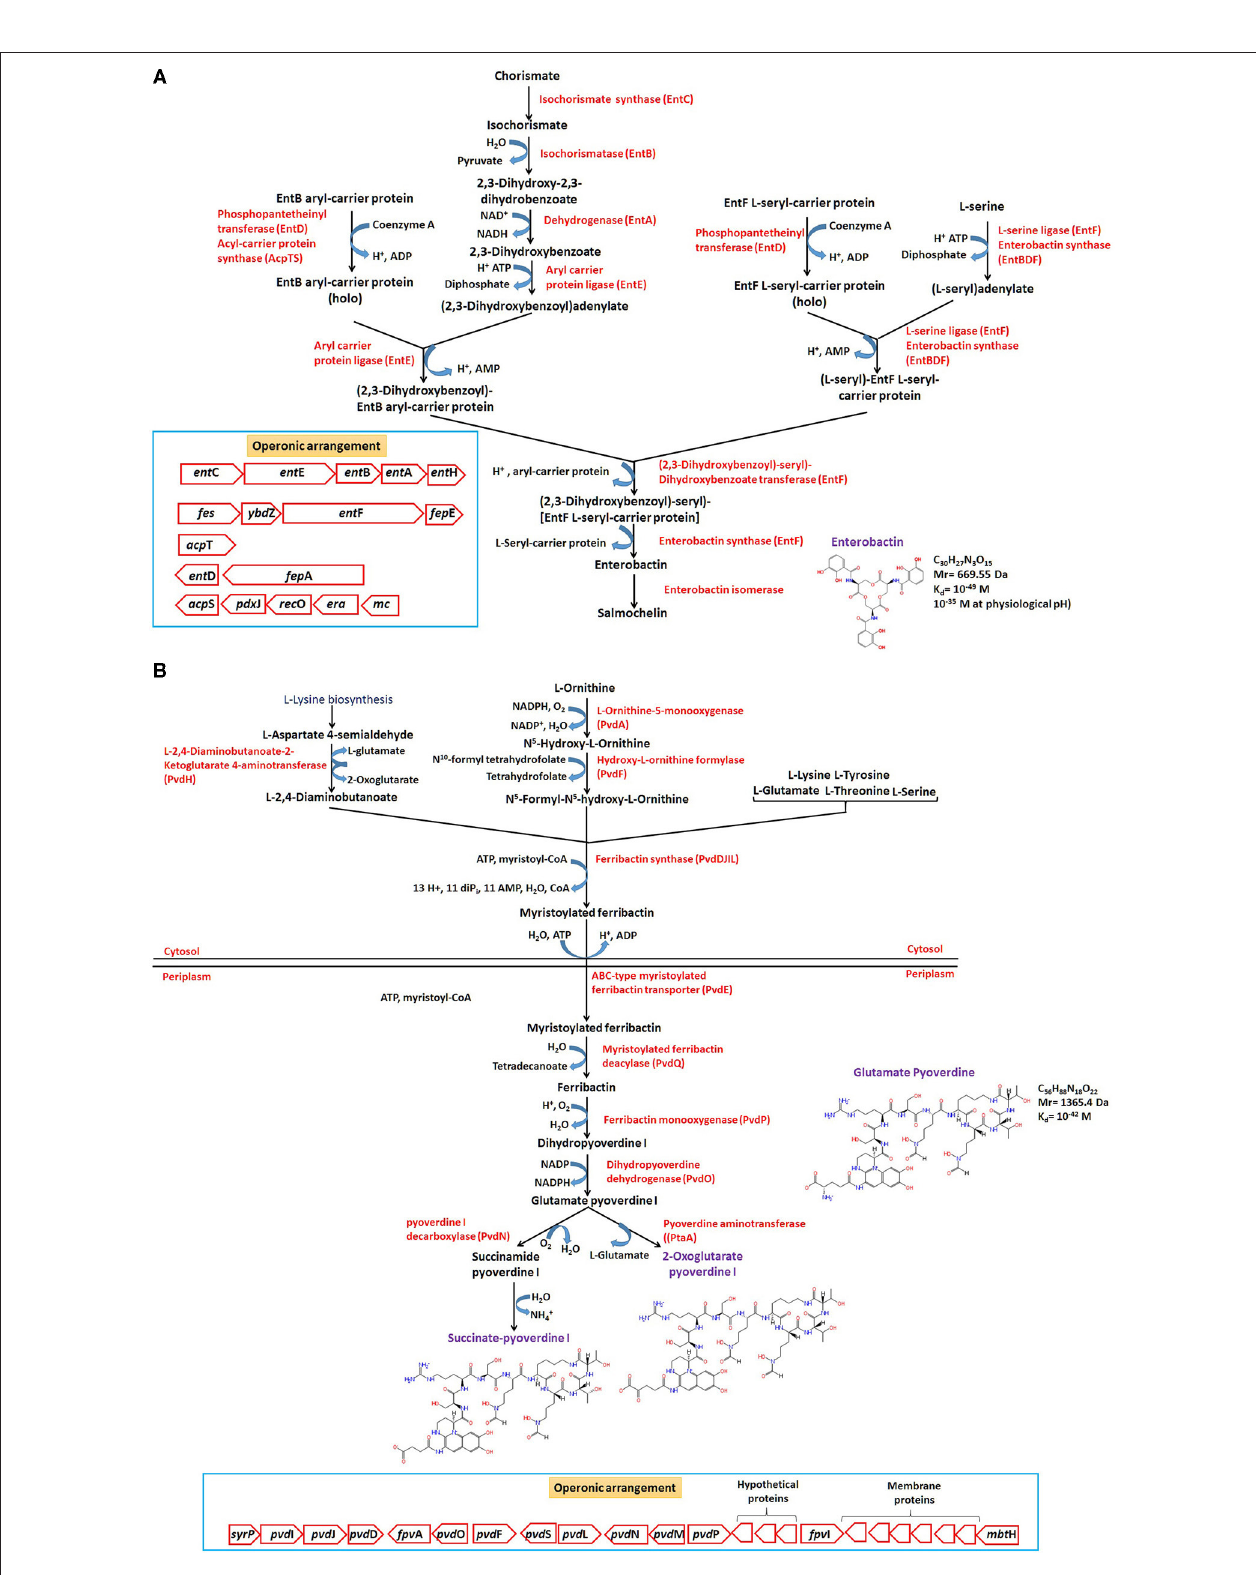
FIGURE 5 | Biosynthetic pathways, reactions (KEGG, MetaCyc, Biocyc, and RAST-SEED based), and operonic (genetic) structure of predominant siderophores produced by E. coli ( Enterobacteriaceae ) and Pseudomonas members. The enzymes responsible for reactions (associated gene product name) are mentioned at each step (in red). The rectangular box in (A,B) denotes the operonic arrangement of the siderophore biosynthesis clusters.